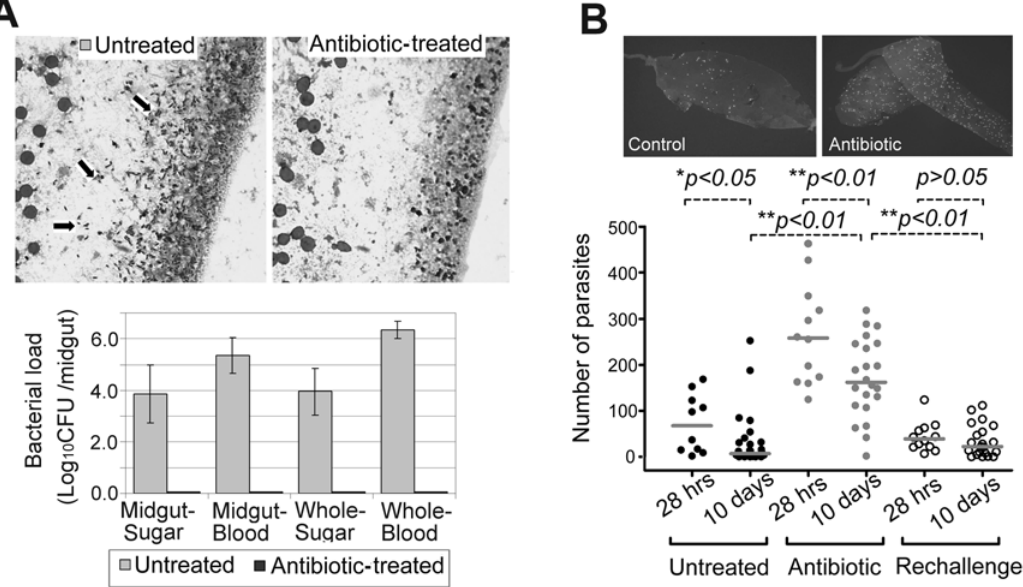
Figure 2. Antibiotic treatment eliminated the natural microbial flora from the mosquitoes’ midguts. (A) The bacterial staining of the midguts of septic mosquitoes (Untreated) and aseptic mosquitoes (Antibiotic-treated), arrows indicating the bacteria (upper panel). Lower panel shows the bacterial loads from the homogenates of midguts (Midgut) or whole mosquitoes (Whole) from septic (untreated) or aseptic (antibiotic- treated) mosquitoes that had fed on either sugar or uninfected blood. (B) Aseptic mosquitoes (antibiotic-treated) became more susceptible to P. falciparum infection compared to the control septic mosquitoes. The upper panel shows IFA (immuno-fluorescence assay) slides of oocysts in the midgut epithelium which were stained with anti-Pfs25 8 days post infection. The lower panel shows the ookinetes numbers in the midgut epithelium (28 hrs) and oocysts counts (10 days) in uninfected septic, aseptic (Antibiotic), and antibiotic-treated mosquitoes that had been re-challenged with natural floral bacteria (Rechallenge). Points indicate the absolute value of parasites counts in individual mosquitoes, and horizontal black bars in each column represent the median value of parasites from three replicates. A Kruskal-Wallis test was used to determine the significance of oocysts numbers ( p , 0.05 or p , 0.01